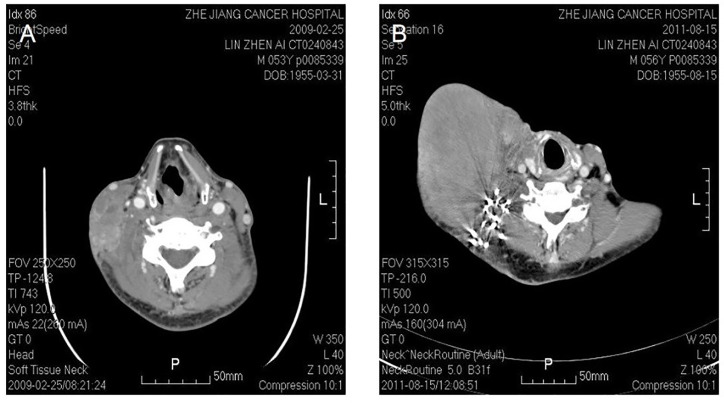
Malignant fibrous histocytoma in right neck. CT shows soft tissue image nearby sternocleidomastoideus in the middle to lower portion of right neck, with illegible margin and patchy enhancement after contrast. The lesion violates circumambient skin, subcutaneous tissue and sternocleidomastoideus (A). The picture on the right shows that recurrent lesion with superficial elcosis is surrounding the right cervical vascular, treated by high density particle (B).